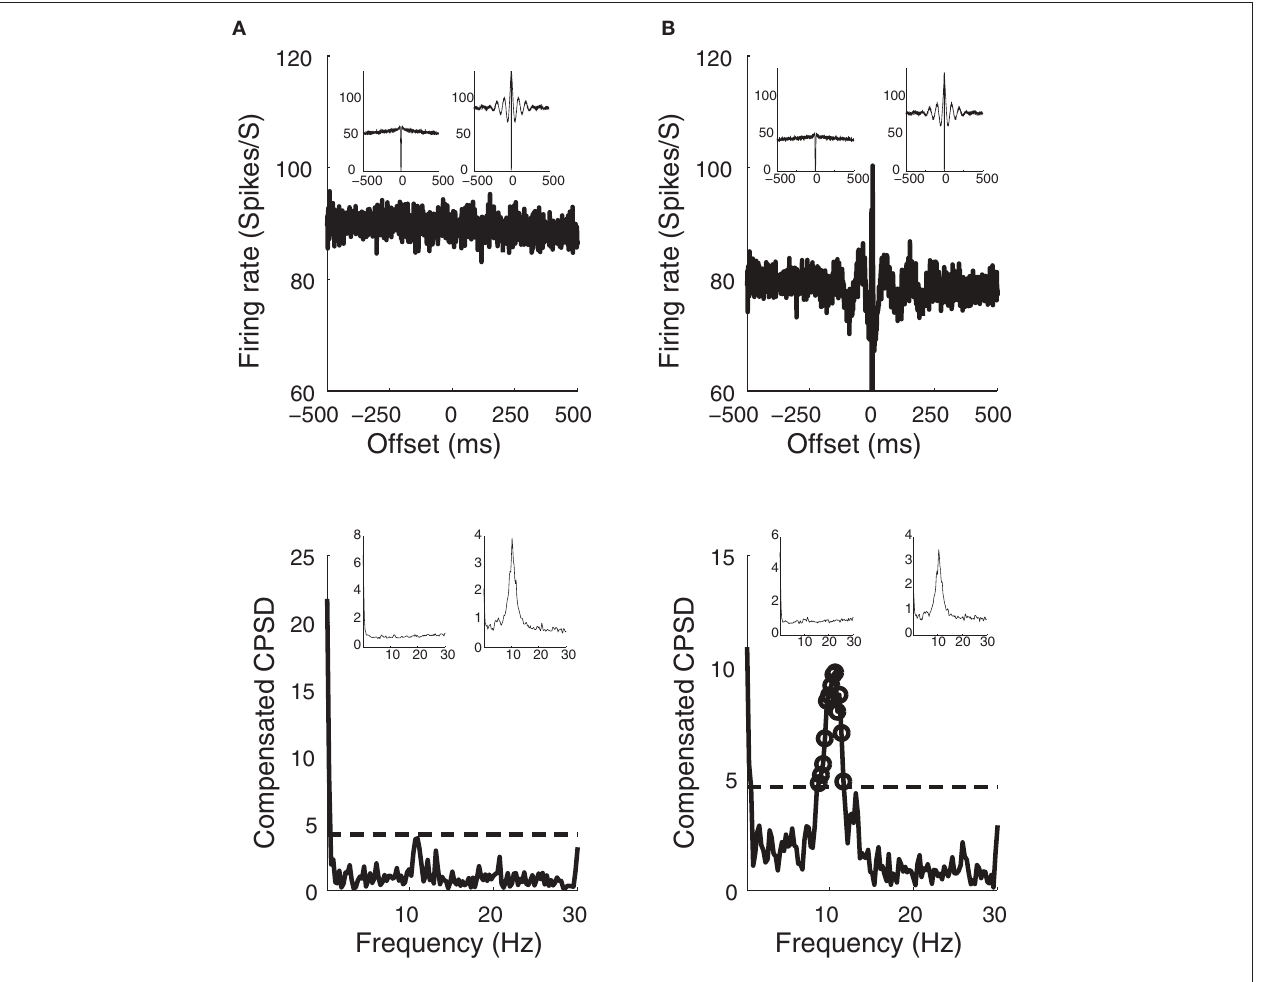
representative shadowing vectors. At the time domain (first row) we can see the large deflection around t = 0 which is caused by the shadowing effect. Both time domain and frequency domain (second row) demonstrate synchronous oscillations (insets show auto correlations and auto-spectrum after shadowing). Confidence levels in the frequency domain are marked with a broken line. Significant samples (at least three continuous) are marked with